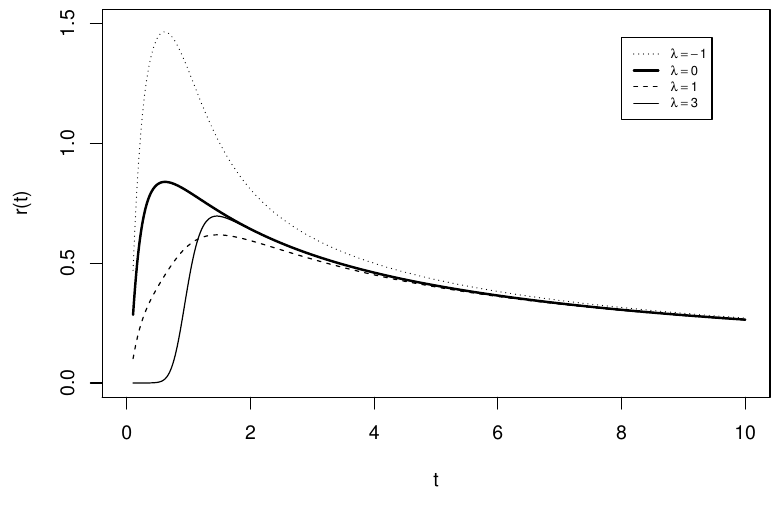
Figure 3. Plots of the risk function of the MLSN model for different values of λ